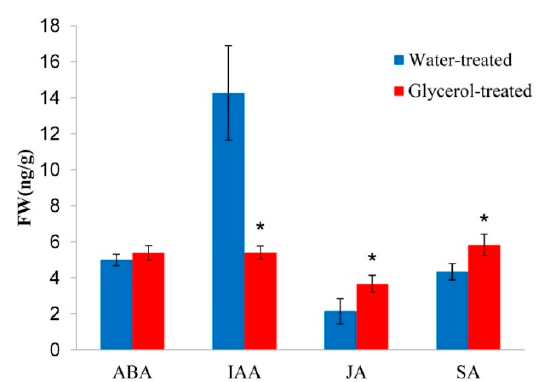
Figure 7. Content of abscisic acid (ABA), auxin (IAA), jasmonic acid (JA), and salicylic acid (SA) levels in water-treated and glycerol-treated Xuezao leaves. Each value is the mean ± SE of three independent biological repetitions. Asterisks indicate a significant difference from the water-treated mock control at p ≤ 0.05 determined by Student’s t -test.